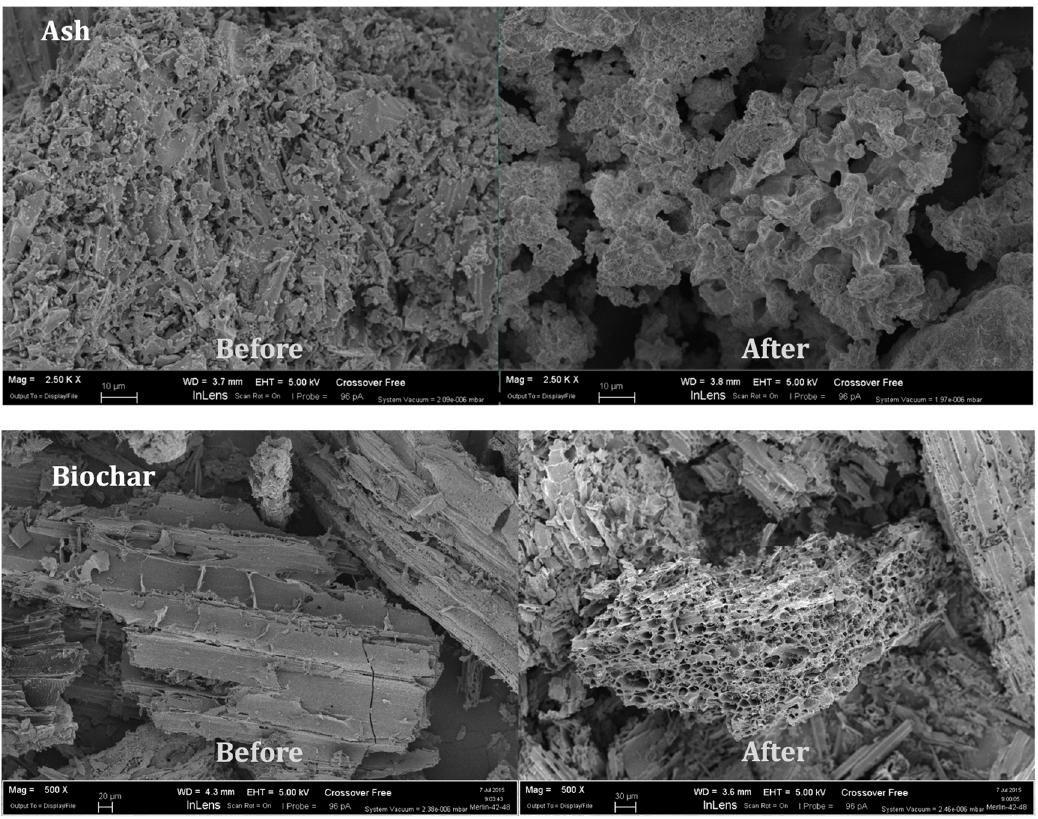
Figure 3. Scanning electron microscopy images for the materials tested – before and after the physical activation process.